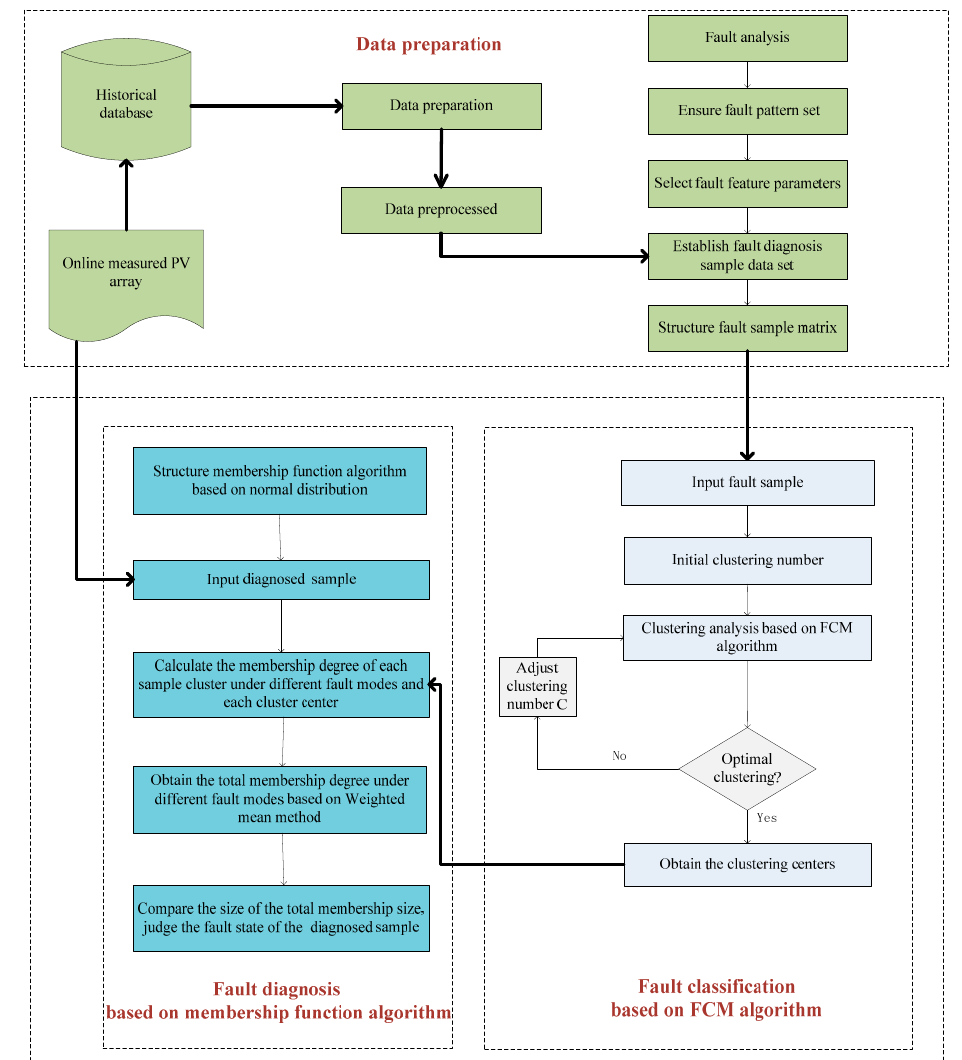
Figure 6. Framework of proposed fault diagnosis technique.